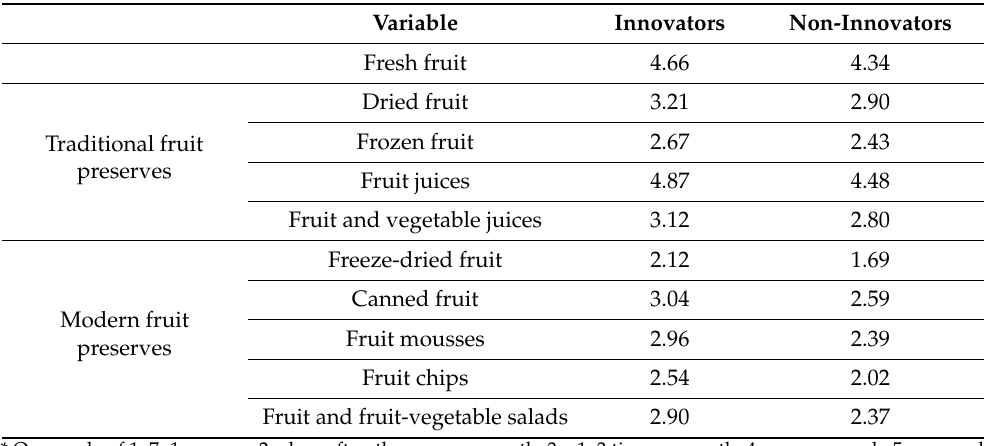
Table A1. Frequency * of consuming fruits and fruit preserves of innovators and